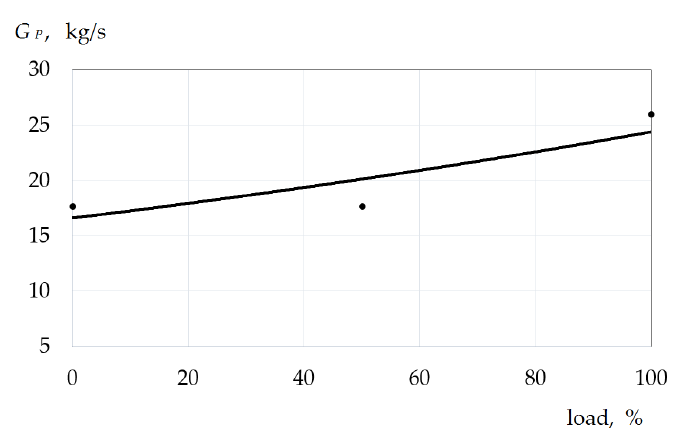
Figure 12. Dependence of primary air flow rate for all combustion chambers on the load value.